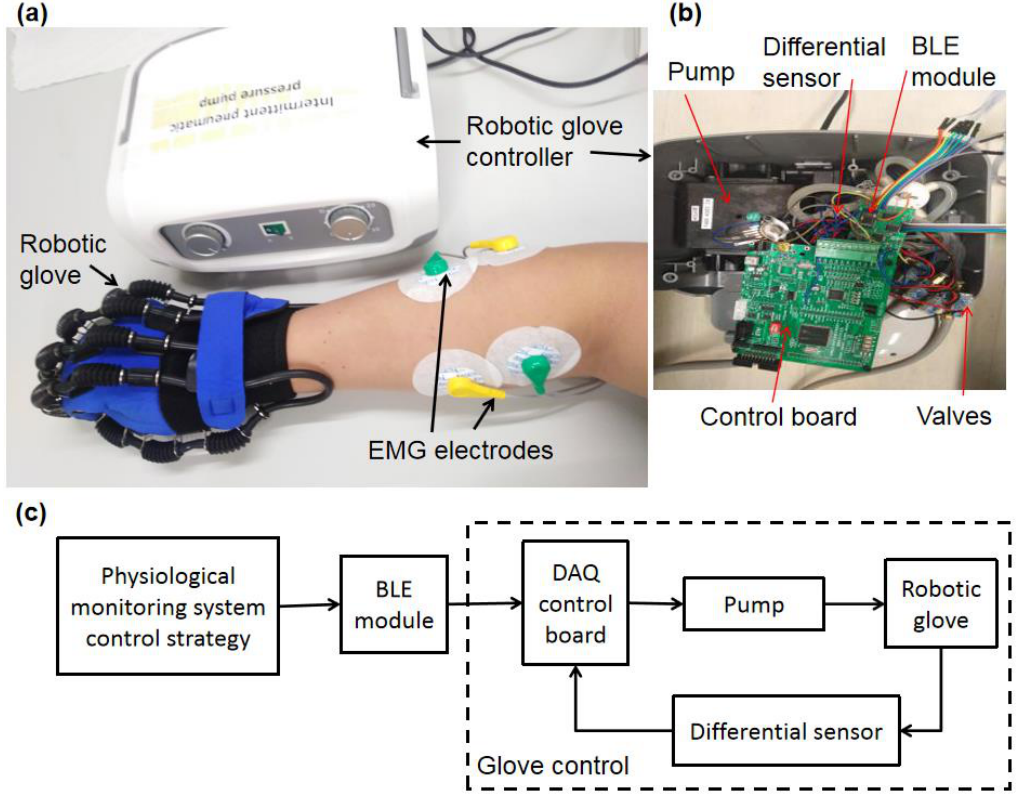
Figure 5. The physiological monitoring system integrating into a pneumatic robotic glove for hand rehabilitation training: ( a ) the robotic glove system; ( b ) the controller; ( c ) the work flowchart.